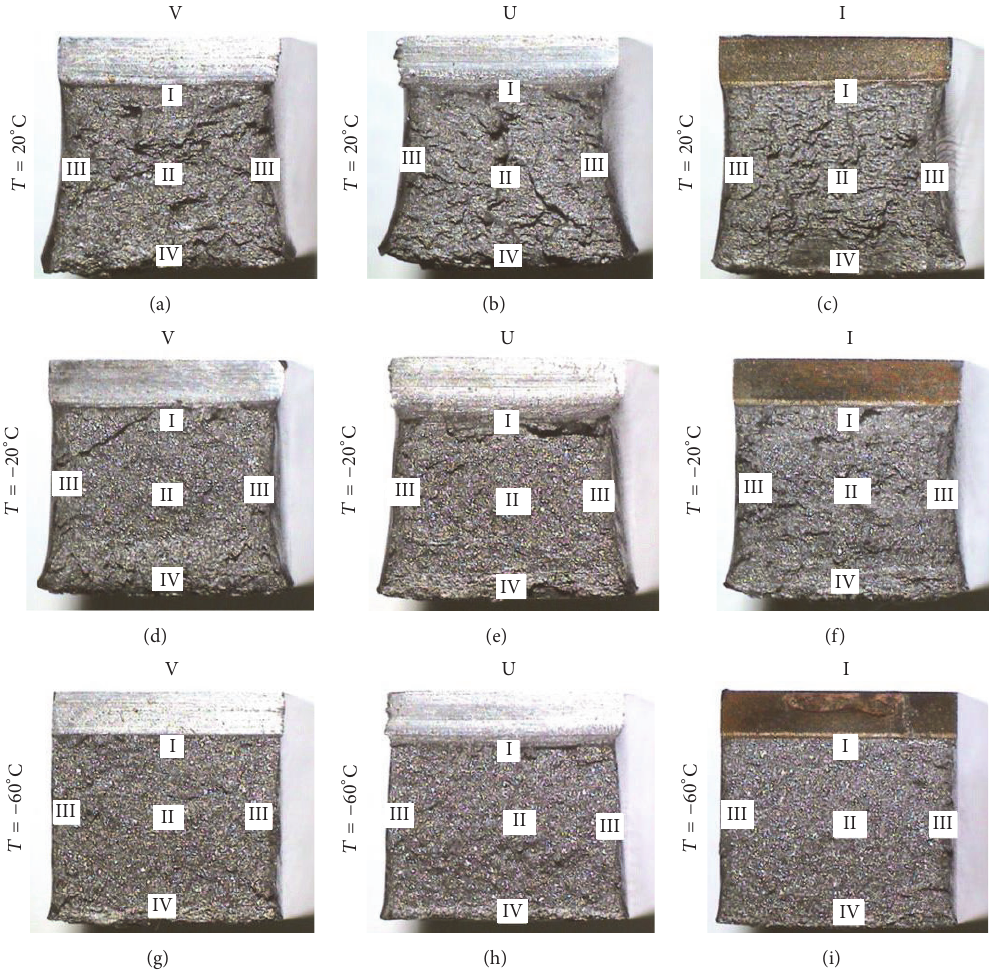
Figure 4: Macroscopic aspects of fracture surface of specimens impact tested at different temperatures. Fracture zones are labelled as (I) crack initiation, (II) crack growth, (III) shear lips, and (IV) final